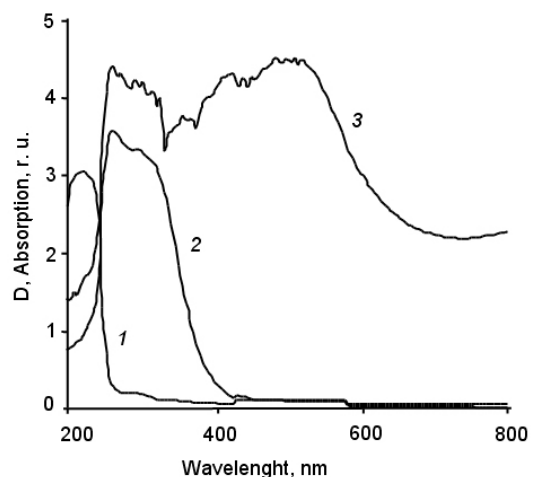
Figure 19. UV-VIS absorption spectra. 1 – PA, 2 – layers of chalcogens on PA surface after 24 h of exposure